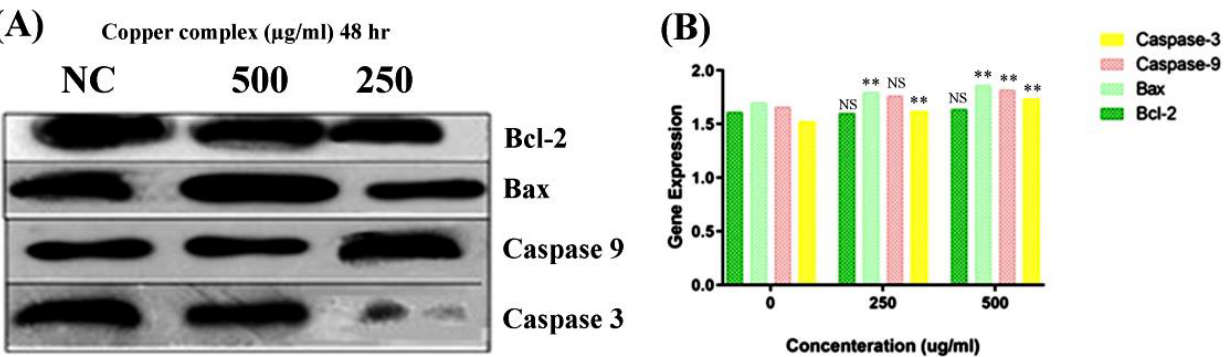
Figure 9. Overall expression ( A ) and relative quantification PCR analysis ( B ) of Bcl-2, Bax, caspase-3, and caspase-9 in response to the copper–Schiff base complex in A549 cells. NC: untreated control. Dose-dependent study on the global expression of Bcl-2, Bax, caspase-3, and caspase-9. The graph shows the fluorescence intensities of the PCR products versus the dose concentration. Data are expressed as the mean ± SD ( n = 3). ** p < 0.01; NS—nonsignificant when compared to control.